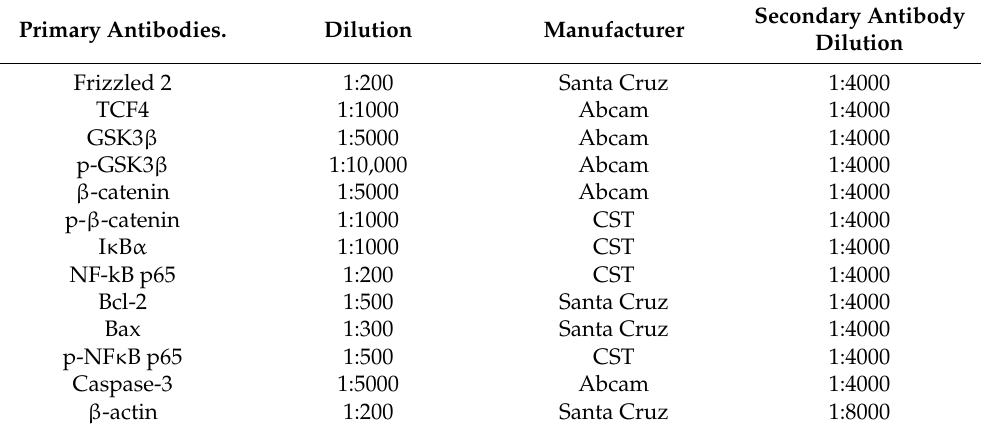
Table 1. Antibodies for Western blotting. Primary